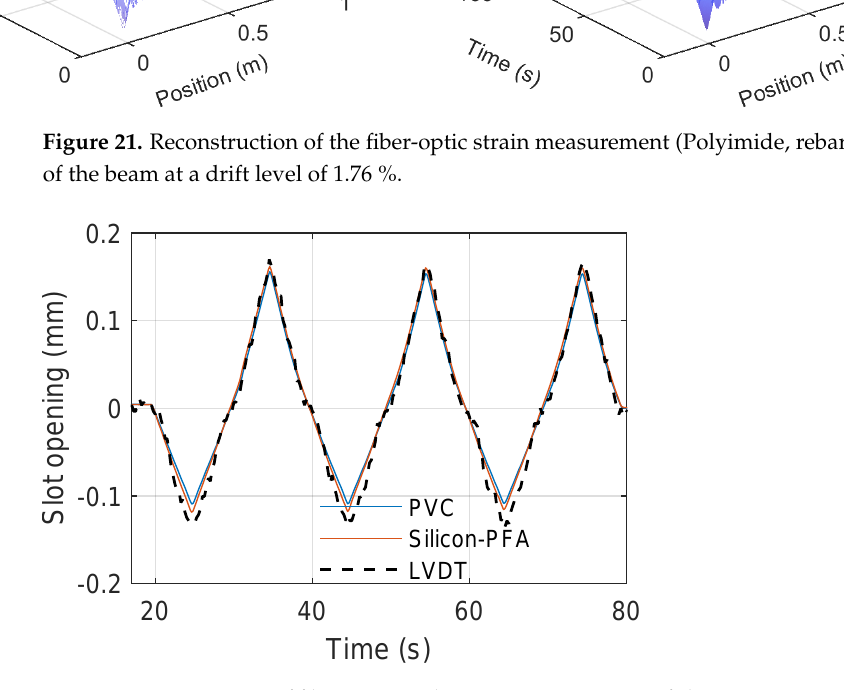
Figure 22. Comparison of fiber-optic and LVDT measurements of slot opening at a drift level of